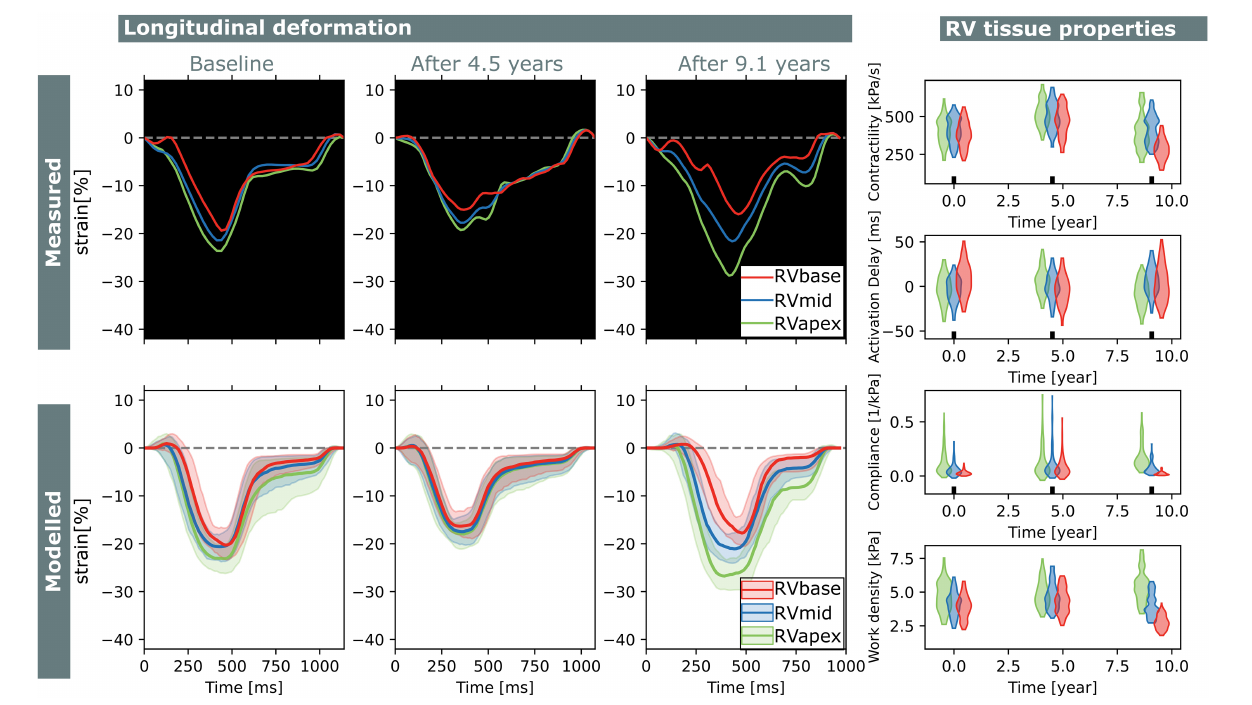
FIGURE 7 | Longitudinal estimations subject 1. Echocardiographic deformation imaging was performed at baseline, and after 4.5 and 9.1 years of follow-up. Computer simulations showed homogeneous RV contractility, activation delay, compliance, and work at baseline. At last follow-up, subject 1 developed an abnormal deformation pattern of the basal RV. Estimation of RV tissue properties from these deformation data showed an apex-to-base heterogeneity in activation delay, compliance, and work